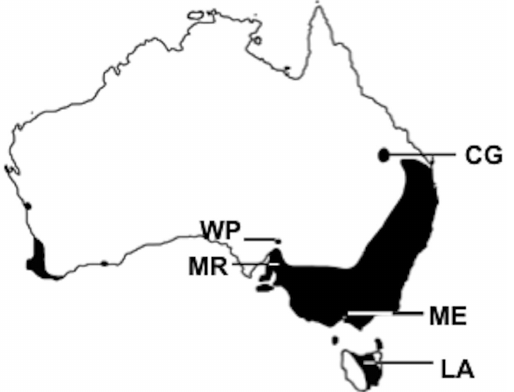
Figure 1. The distribution of Heteronympha merope . The distribution of H. merope across the Australian continent is indicated in black, and the location of collection sites of samples used in the common garden experiment are shown: Carnarvon Gorge (CG); Wilpena Pound (WP): Mt Remarkable (MR): Melbourne (ME); and Launceston (LA). Figure adapted from Norgate et al. [52].